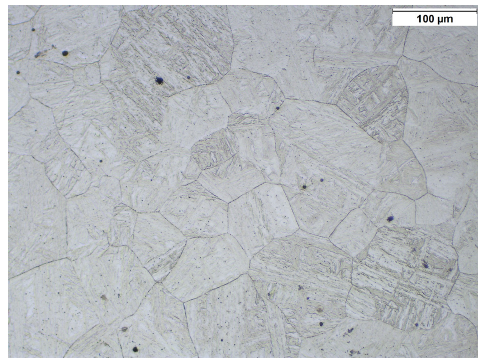
Figure 9. Prior austenitic grains for the austenitizing temperature of 1300°C. Etchant: Teepol. OM.